Question: Describe this figure in one sentence.
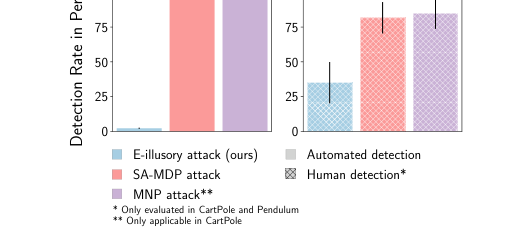
Answer: Different adversarial attacks are shown on the x-axis, with detection rates on the y-axis. We see that both the automated detec- tor as well as human subjects are able to detect SA-MDP and MNP attacks, while ϵ-illusory at- tacks are less likely to be detected.